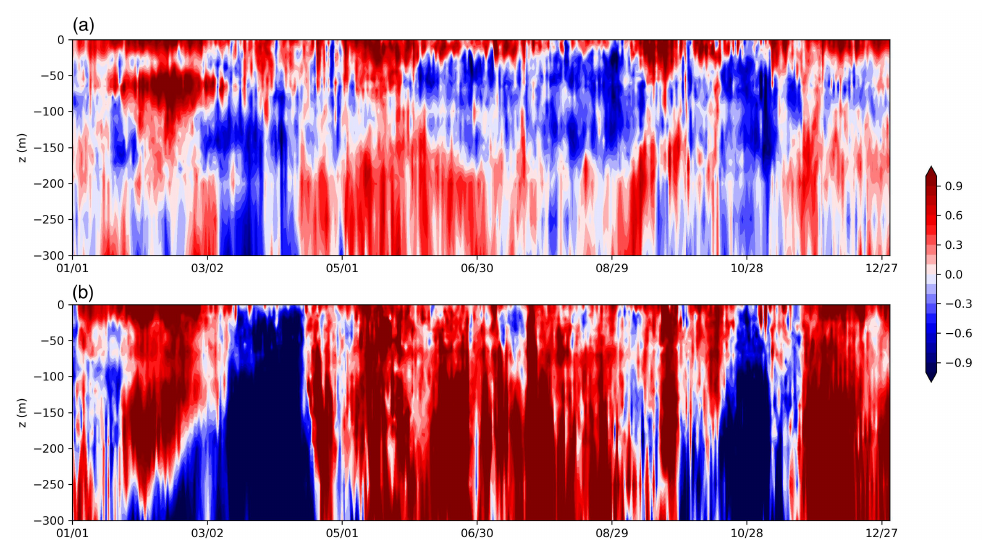
Figure 9. Time sequences for the vertical distribution of the skewness for vorticity PDF ( a ) with and ( b ) without the reefs (atolls) obtained from XA-FVCOM during 2009.